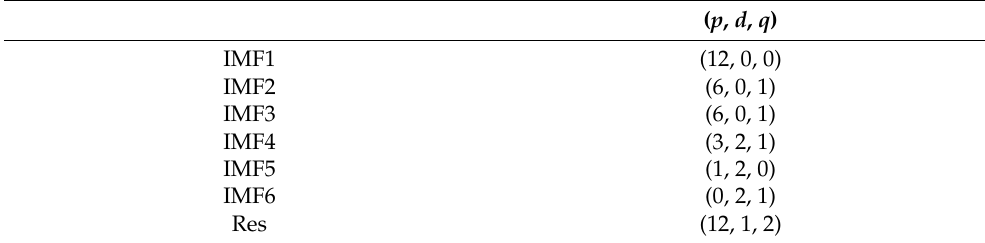
Table 2. The best parameter combination of ARIMA, with p ranging from 0 to 12, and d and q ranging from 0 to 3.